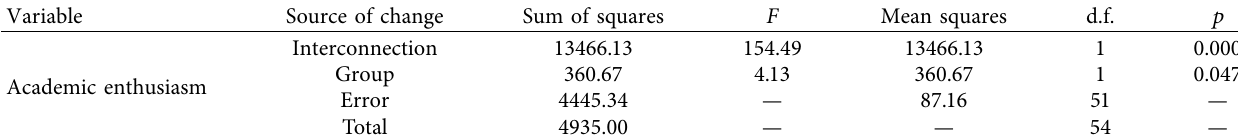
Table 4: ANCOVA results for the difference between the mean scores of academic enthusiasm in the experimental and control groups. Variable Source of change Sum of squares F Mean